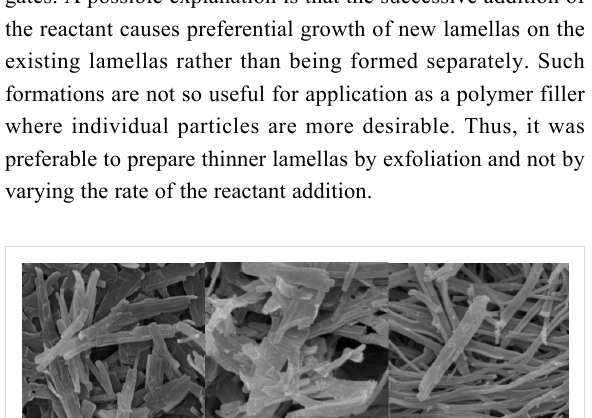
as a filler in a polymer matrix, which implies that possible ways for large-scale synthesis of this material were investigated.